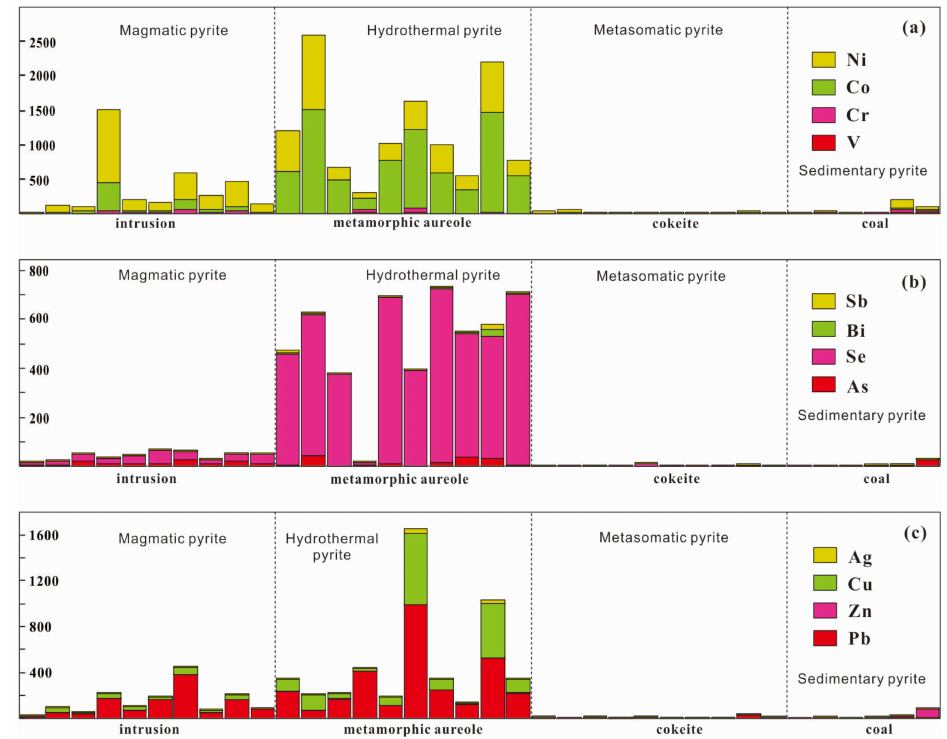
Figure 6. Histograms of element abundance in the different pyrite generations from the Yuandian Coal Mine. ( a ) Siderophile elements; ( b ) sulphophile elements; ( c ) metallic